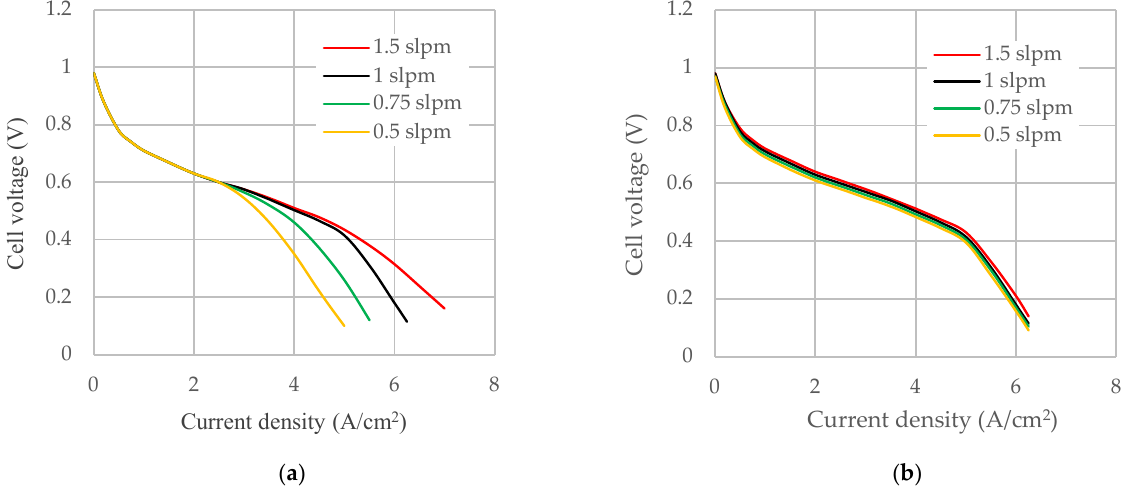
Figure 11. The effect of different inlet flow rates in ( a ) anode and ( b ) cathode on cell performance. The cell is further tested with four different cathode flow rates while maintaining the anode flow rate constant at 1 slpm. As can be seen in Figure 11b, lowering the cathode flow rate has little impact on the performance and does not have the same drastic conse- quences as lowering the anode flow rate. Although minor changes may be seen across the four simulated flow rates, they are only around 2% of the produced current